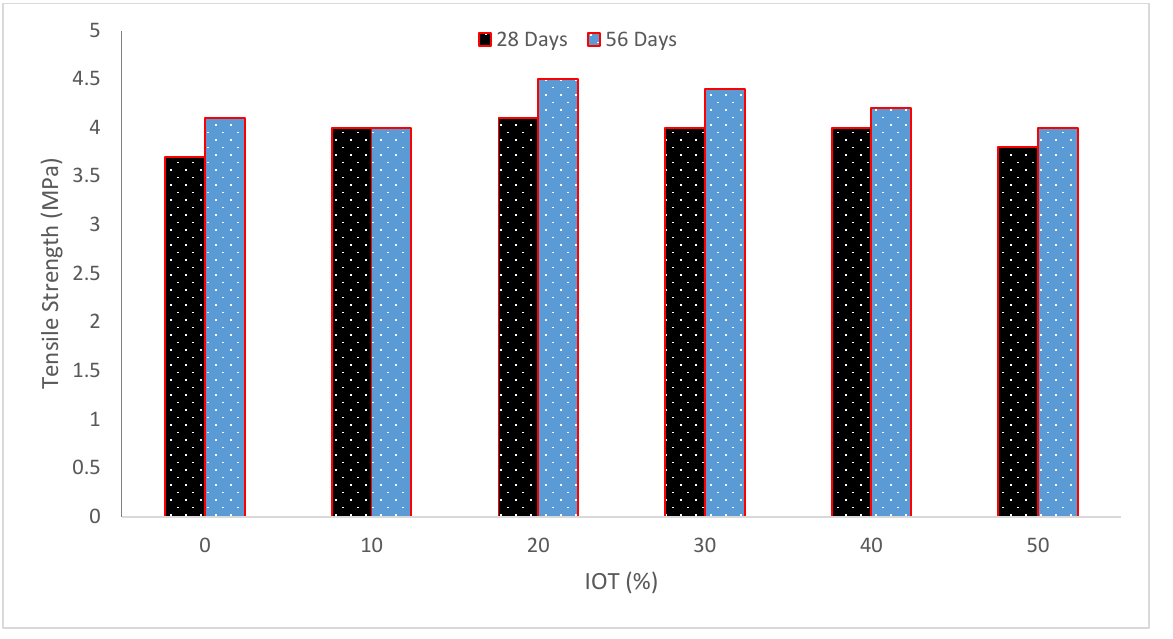
Figure 10. Tensile strength (data source [36]). Table 4. Summary of tensile strength.